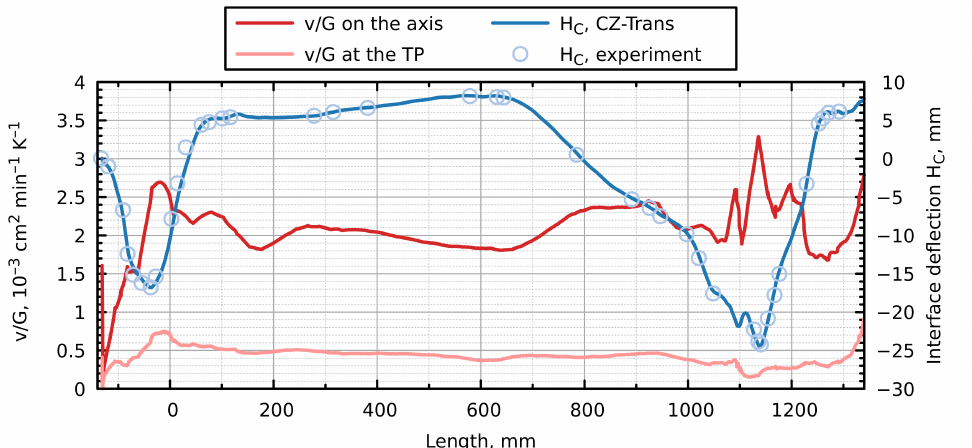
Figure 2. Calculated v / G ratio on the axis and at the triple point (TP, left axis) and calculated and experimentally measured crystallization interface deflection H C (right axis), defined as the vertical distance between the interface at TP and on the axis.